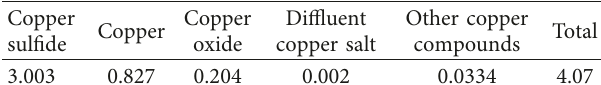
Table 2: Chemical composition of copper compounds in raw materials (wt.%).